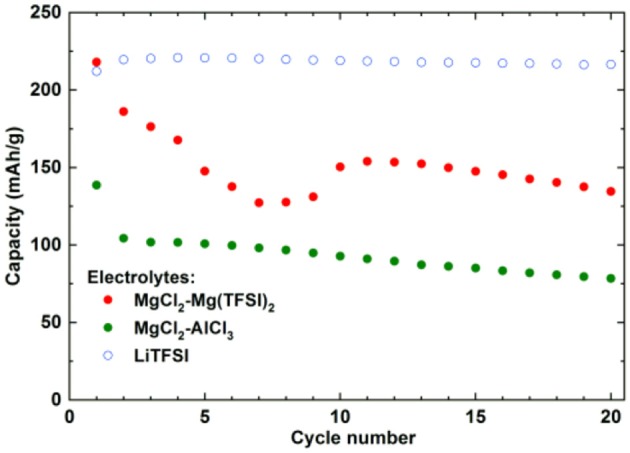
Comparison of capacity retention of PAQS in Li 1 M LiTFSI in DME:DOL = 1:1 (vol%) and two Mg electrolytes [Mg(TFSI)2-2.5MgCl2, MgCl2-0.3AlCl3] at current density of 50 mA/g in voltage window from 0.5 to 2.5 V. Adapted with permission from Bitenc et al. (2015). Copyright Wiley-VCH.